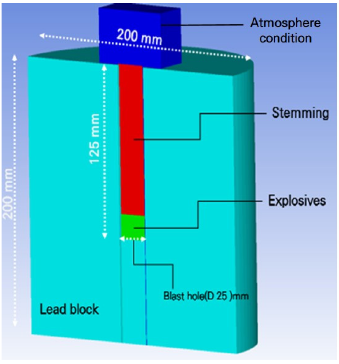
Figure 7. AUTODYN numerical model of the lead block. Table 4. Jones–Wilkins–Lee (JWL) and Chapman–Jouguet (C ‐ J) characteristic values (emulsion ex ‐